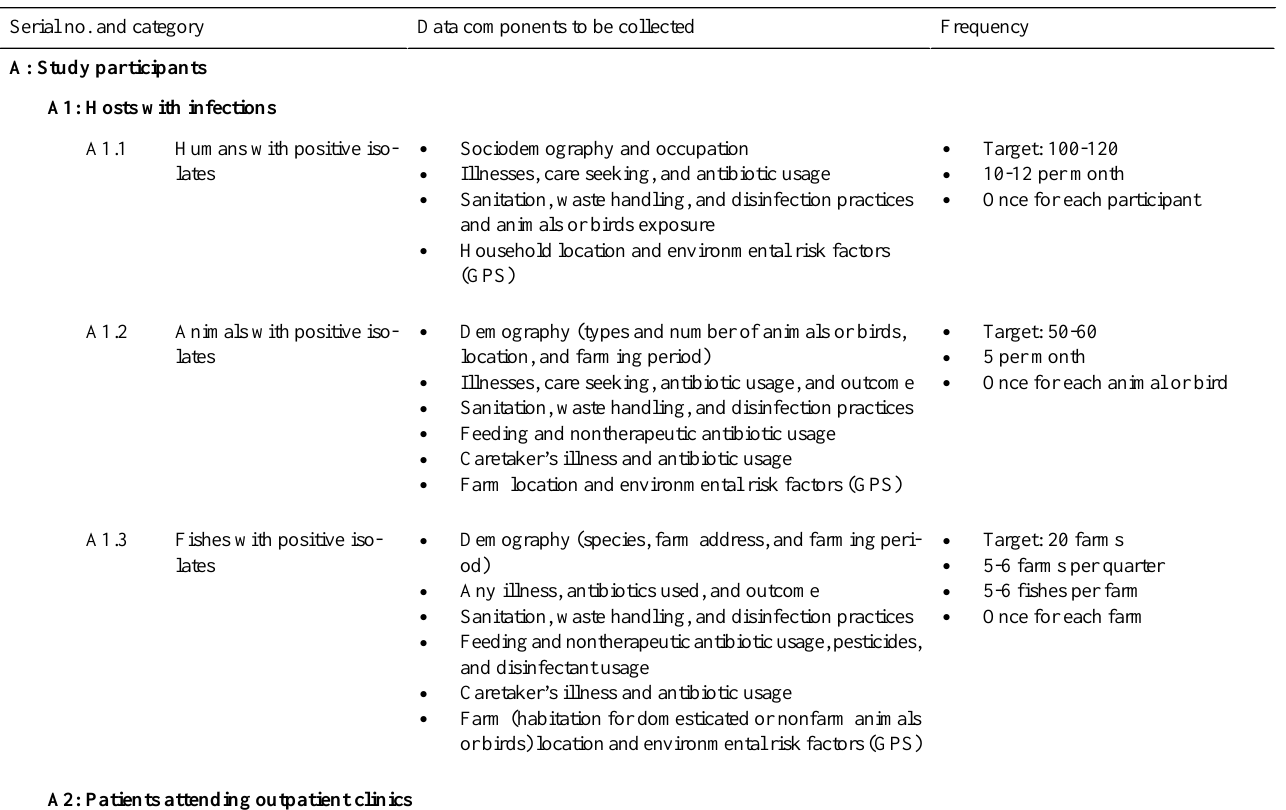
Table 2. The data components to be collected from various study participants.